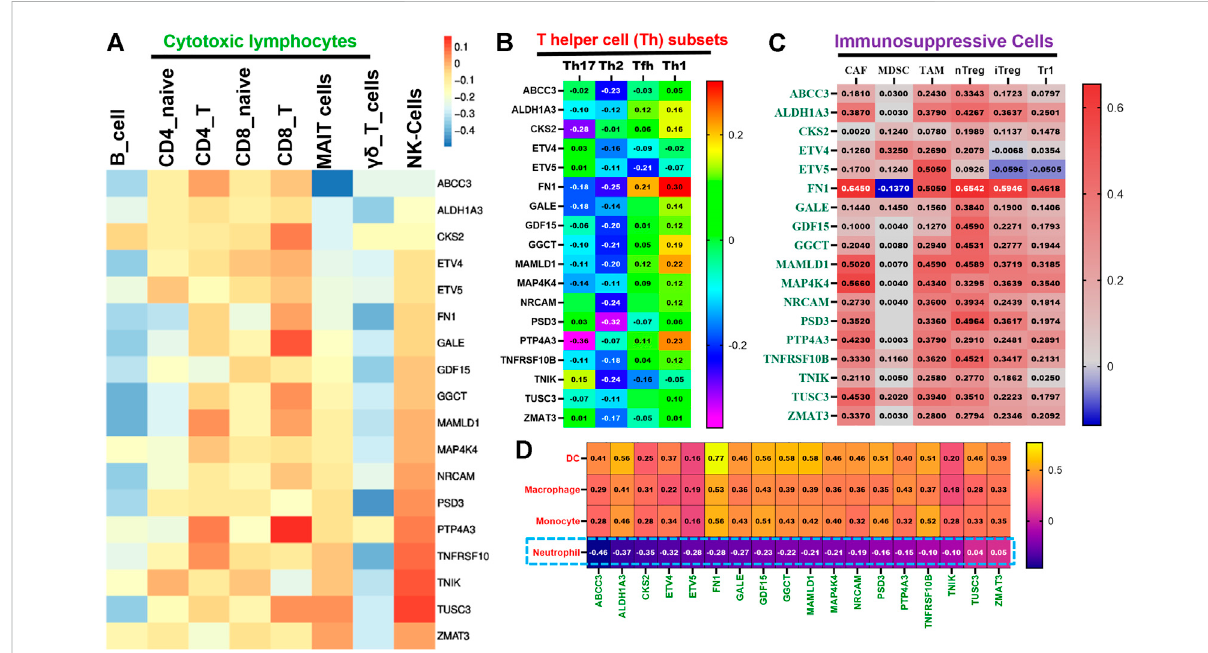
FIGURE 5 TTEPsdemonstratedasigni fi cantassociationwiththeT-cellexclusionmechanism ofimmune-invasivephenotypesinTHCA.Heatmapplots of the mRNA association with tumor in in fi ltrations of cytotoxic lymphocytes (A) , T-helper cells (B) , immunosuppressive cells (C) , myeloid cells, and neutrophils (D) in TCGA-THCA